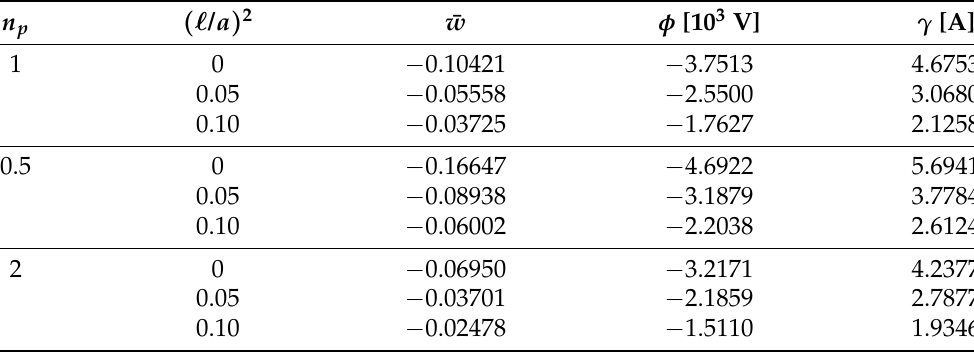
Table 8. Displacement ¯ w , electric and magnetic potential φ and γ , of a square nanoplate in central point ( a /2, b /2 ) for different values of nonlocal parameter ( (cid:96) / a ) 2 and n p (UDL; q = 0 N/m 2 ,